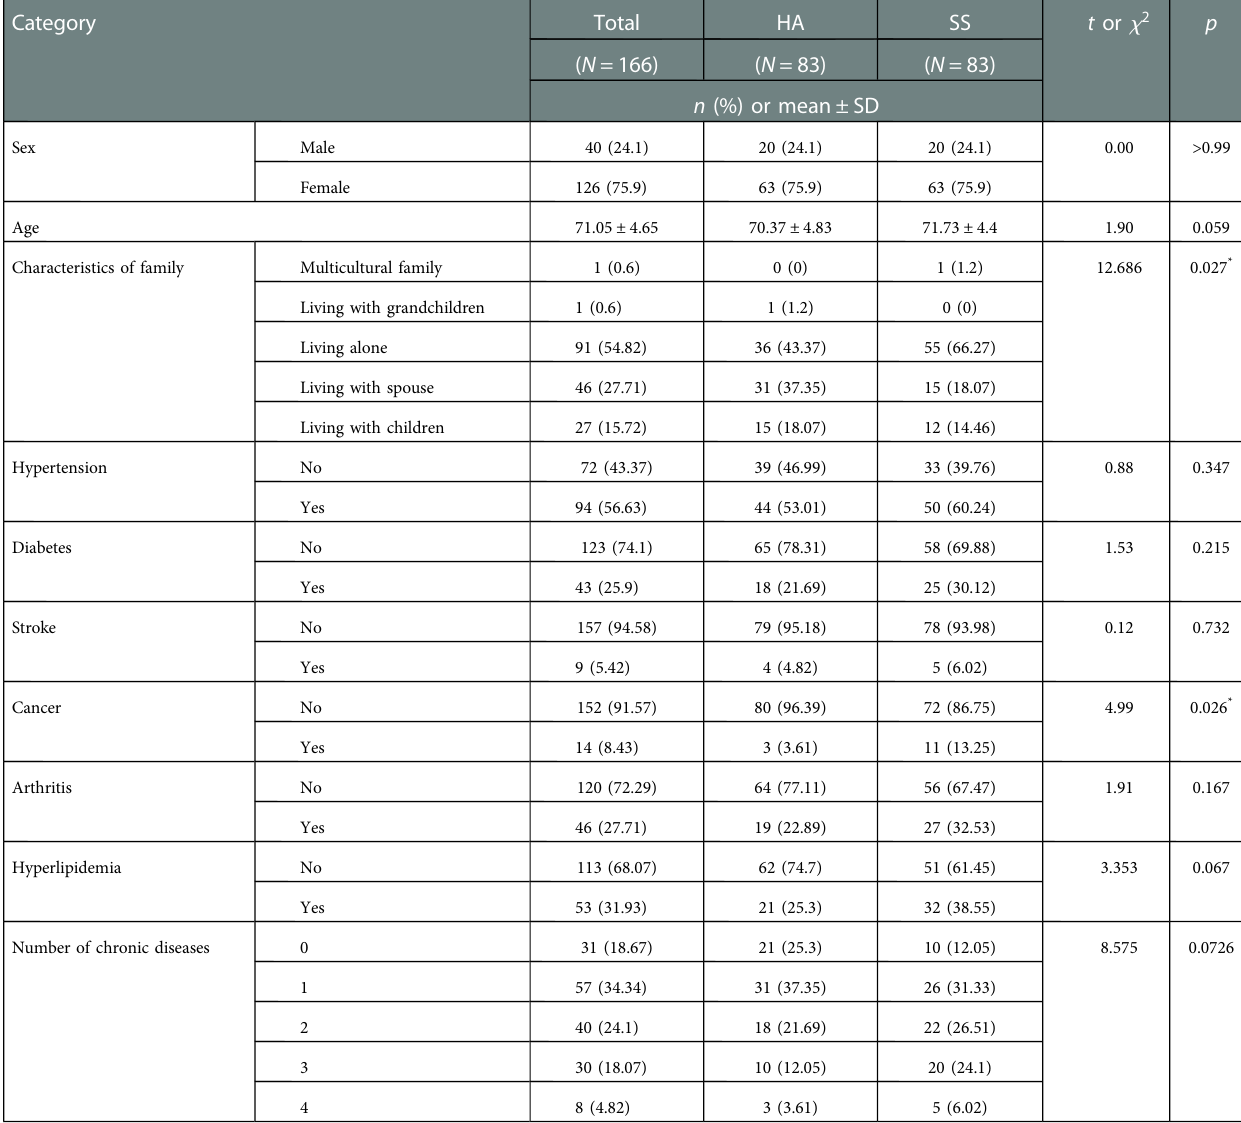
TABLE 2 General characteristics and health status of participants.